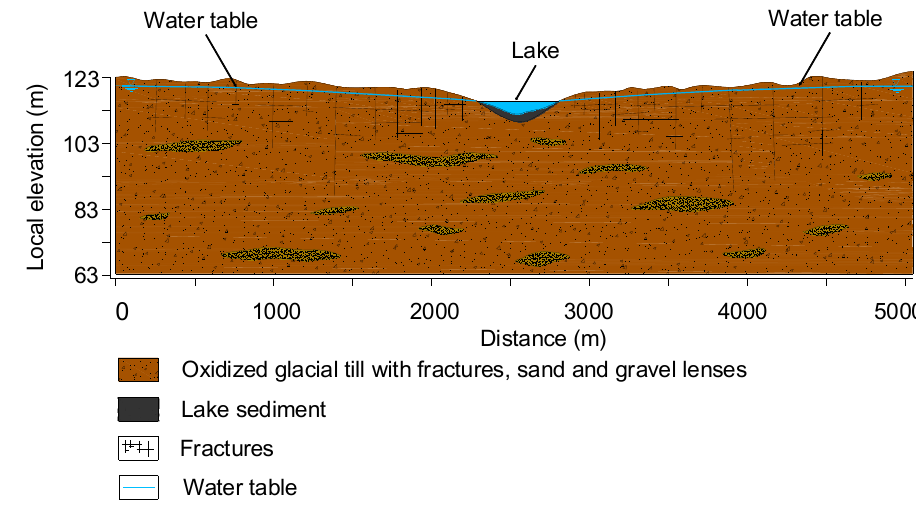
Figure 1. The conceptual model shown in